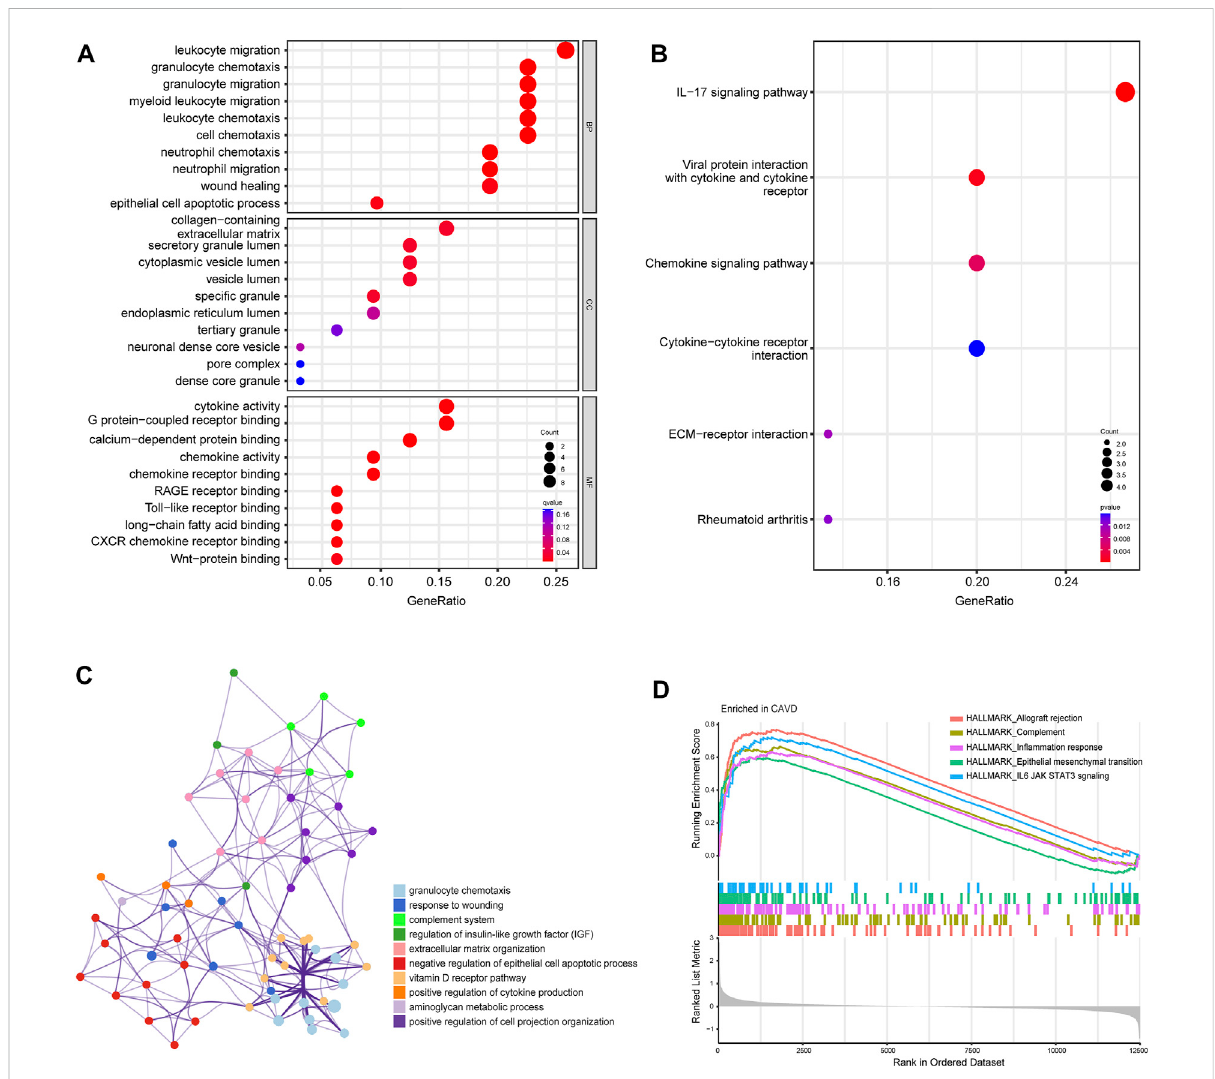
FIGURE 3 Biofunctionalenrichment analysis ofdifferentially expressed genes (DEGs). (A) Gene Ontology functional enrichmentanalyses ofDEGs and the top10biologicalprocess(BP),cellularcomponent(CC),andmolecularfunction(MF)terms. (B) KyotoEncyclopediaofGenesandGenomespathway enrichment analyses of DEGs. The size of dots represents the count of DEGs enriched to the pathway, and the color from red to blue represents the change in p -value. (C) Network of the top 12 clusters of enriched terms in Metascape. Cluster identi fi cation is represented by color; similarity score is represented by edge thickness. (D) Results of gene set enrichment analysis (GSEA) showing the top fi ve hallmark pathways most associated with CAVD